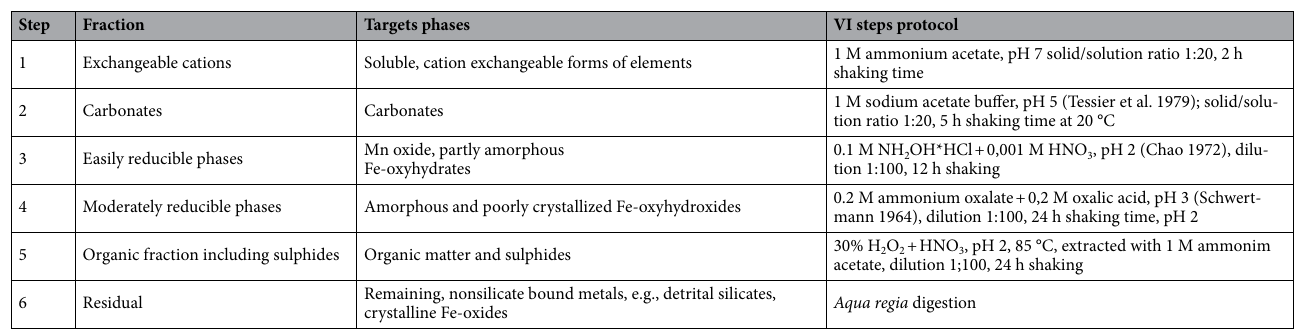
Table 1. Chemical fractionation